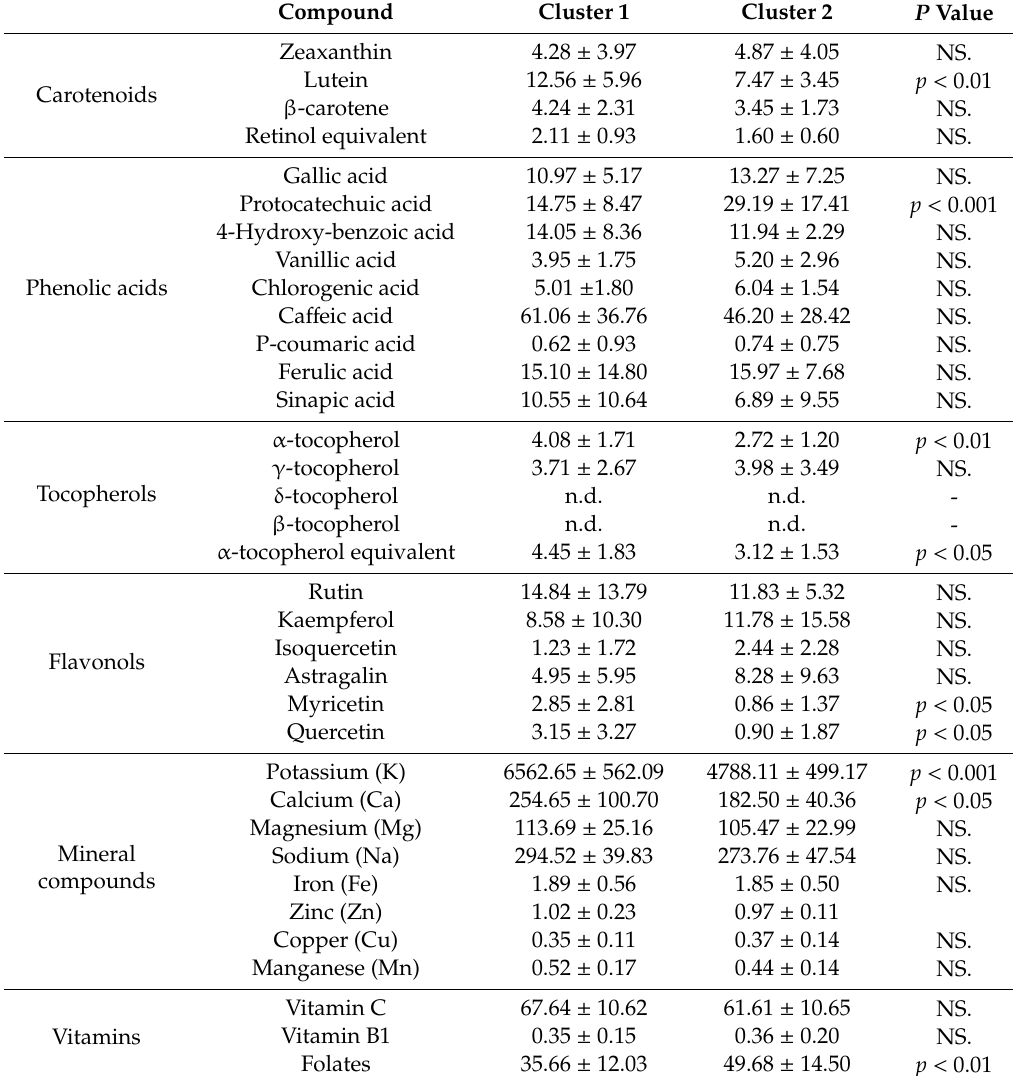
Table 9. Variable levels divided into groups of pumpkin